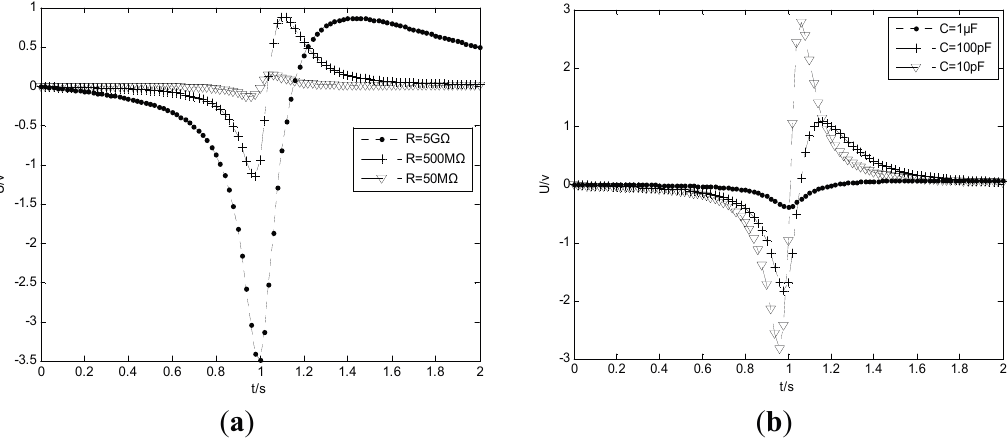
Figure 14. System time responses for different resistances ( a ) and capacitances ( b ).